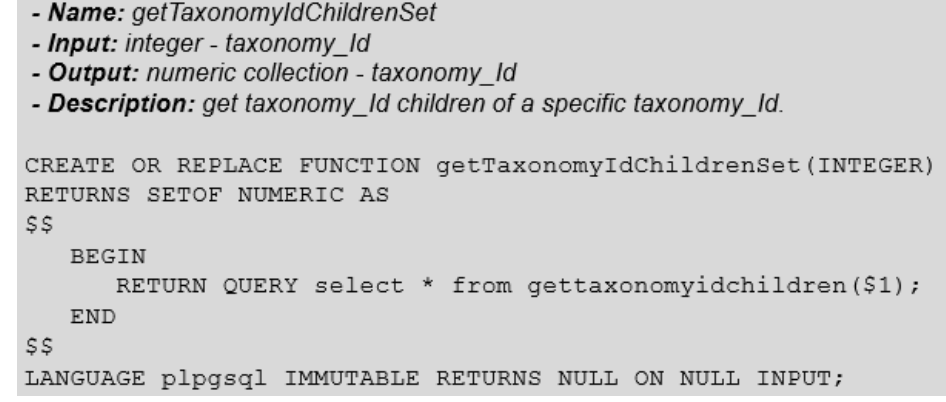
Figure 9. Function: